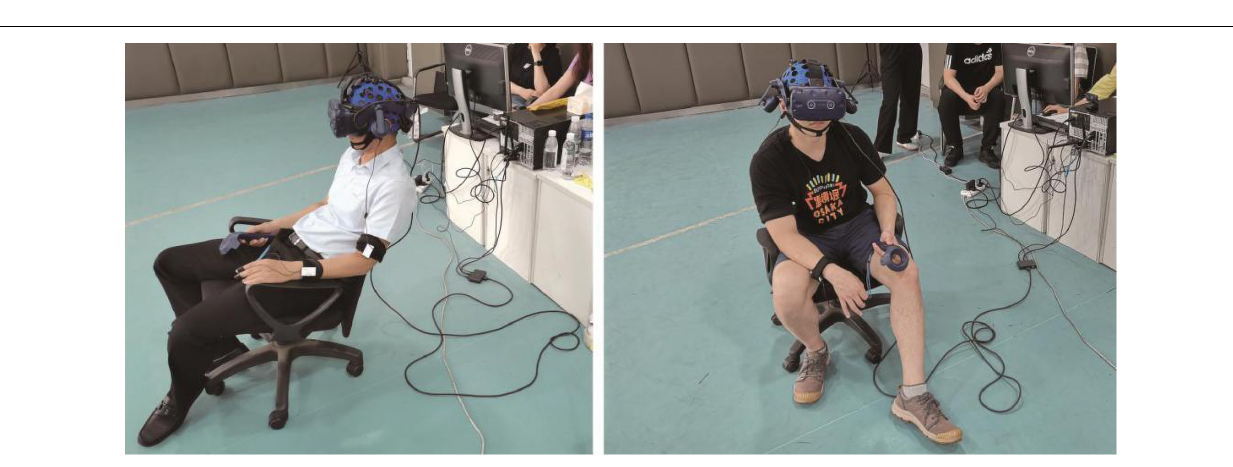
Frontiers in Psychology |